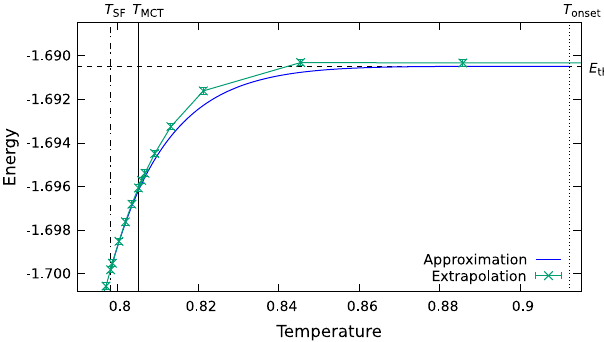
FIG. 8. Numerically extrapolated asymptotic energy (data with errors) and approximated asymptotic solution of dynamical equations (solid line).